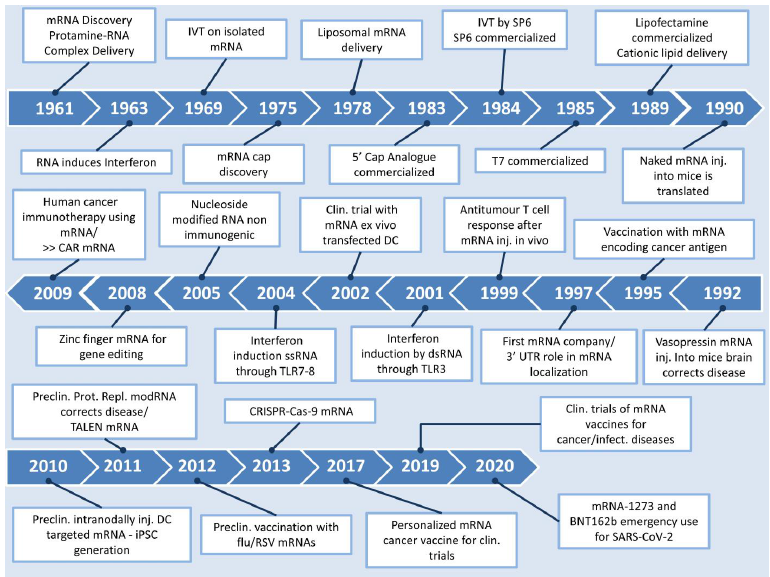
Figure 1. Timeline of major events in the history of mRNA. Clin: clinical, Preclin: preclinical, iPSC: induced pluripotent stem cells, Inj: injected, CAR: chimeric antigen receptor, DC: dendritic cells [8– 10,19–37].